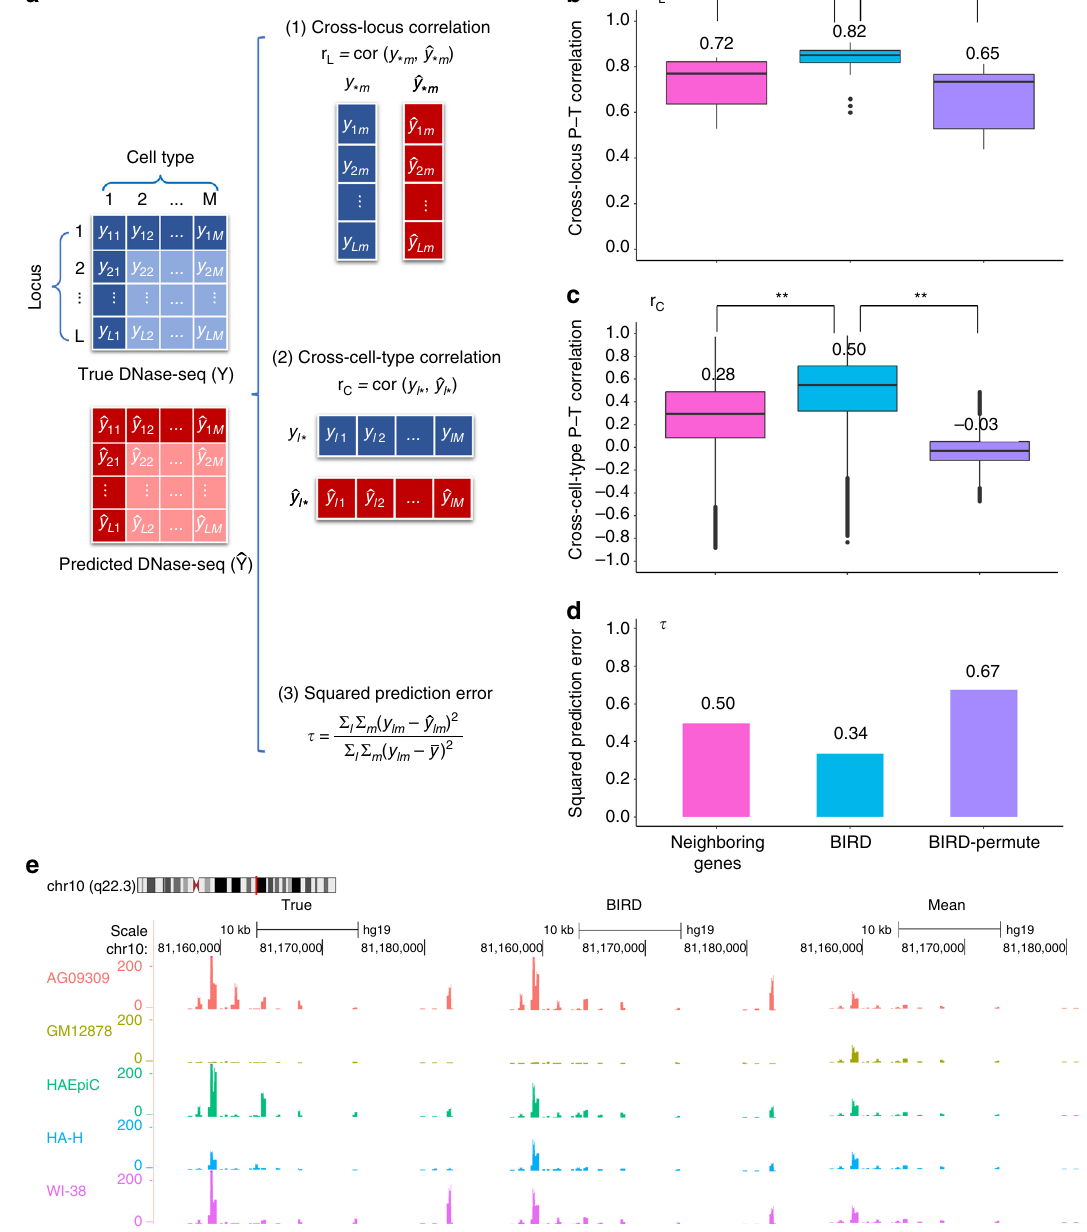
Fig. 2 Evaluation of BIRD. a Statistics used to evaluate prediction accuracy. b Cross-locus P – T correlation ( r L ) for different methods. For each method, the distribution and mean of r L from the 17 test cell types are shown. *Two-sided Wilcoxon signed-rank test p -values < 10 − 4 for comparing two methods ( n = 17 for each test). c Cross-cell-type P – T correlation ( r C ) for different methods. For each method, the distribution and mean of r C from the 912,886 genomic loci are shown. **Two-sided Wilcoxon signed-rank test p -values < 10 − 15 for comparing two methods ( n = 912,886 for each test). d Squared prediction error ( τ ) for different methods. Wilcoxon signed-rank test was not conducted here since there is only one τ for each method. e An example of true and predicted DNase-seq signals for fi ve different cell types. “ True ” : true DNase-seq bin read count; “ BIRD ” : DH signal predicted by BIRD; “ Mean ” : the average DH signal of training cell types. For “ BIRD ” and “ Mean ” , signals are transformed back from the log-scale to the original scale. ( b , c ) The box in each boxplot denotes the 1st (Q1) to 3rd (Q3) quartile of the data, the line in the middle of the box is the median, and the lower and upper whiskers represent the 1.5 interquartile range from Q1 and Q3, “ Methods ” ). On the basis of these results, we used the aggregated model, termed BIRD, in all subsequent analyses to predict DH levels for each individual locus. A systematic benchmark analysis shows that BIRD not only produces the best prediction performance compared to other methods, but also offers computational ef fi ciency suitable for big data regression (Supple- mentary Note 1; Supplementary Figs. 4 – 6).